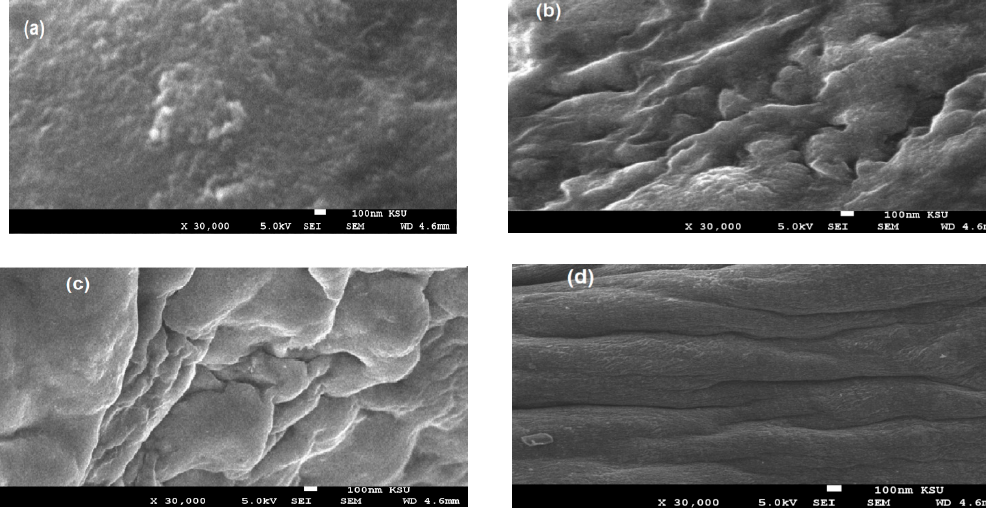
Figure 7. SEM images of the EOSNP1 films, prepared using different percentages of PWs ( a ) 5, ( b ) 10, ( c ) 15, and ( d ) 20 wt